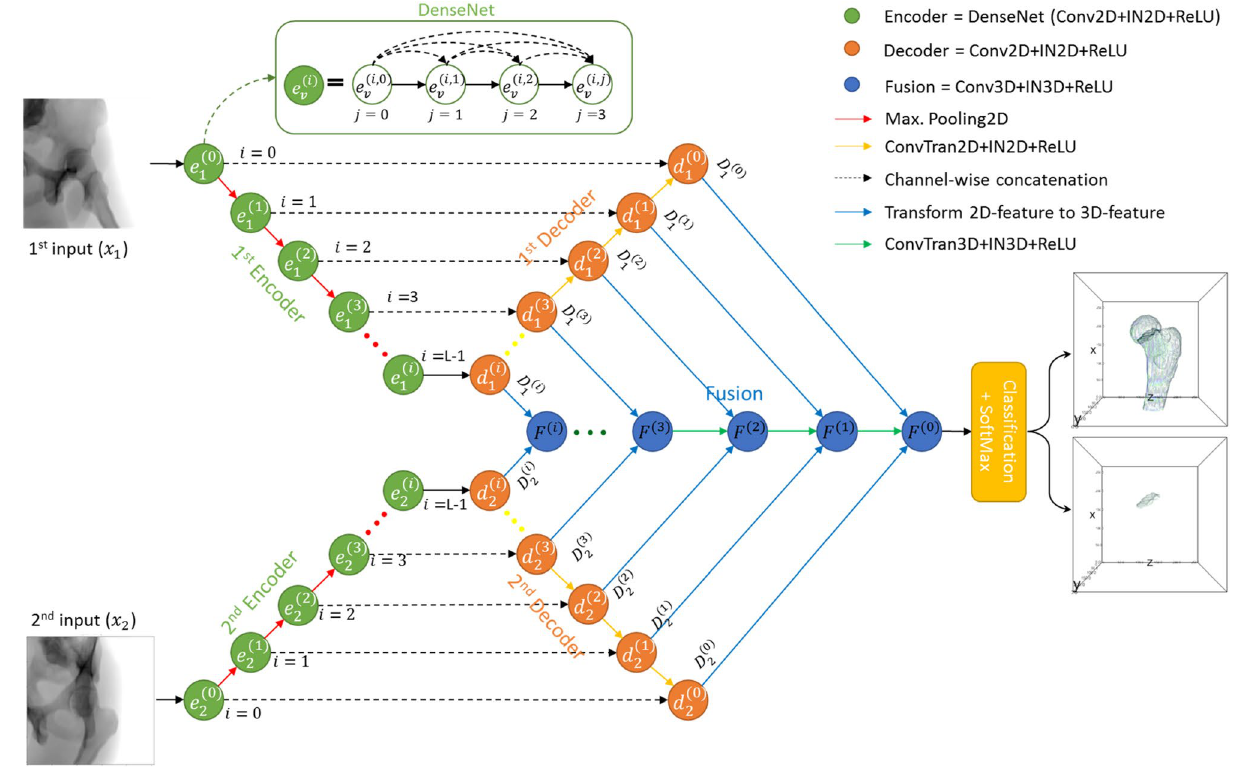
Figure 1. The proposed network for 3D reconstruction of femoral fracture with fracture detail is called 3DReconNet. The network includes Encoder, Decoder, and Fusion modules represented by green, orange, and blue circles. The solid black, red, yellow, and blue arrows indicate 2D convolutional operations, downsampling, upsampling and fusion operations, respectively. While the black dash arrows indicate channel-wise concatenations between encoder and